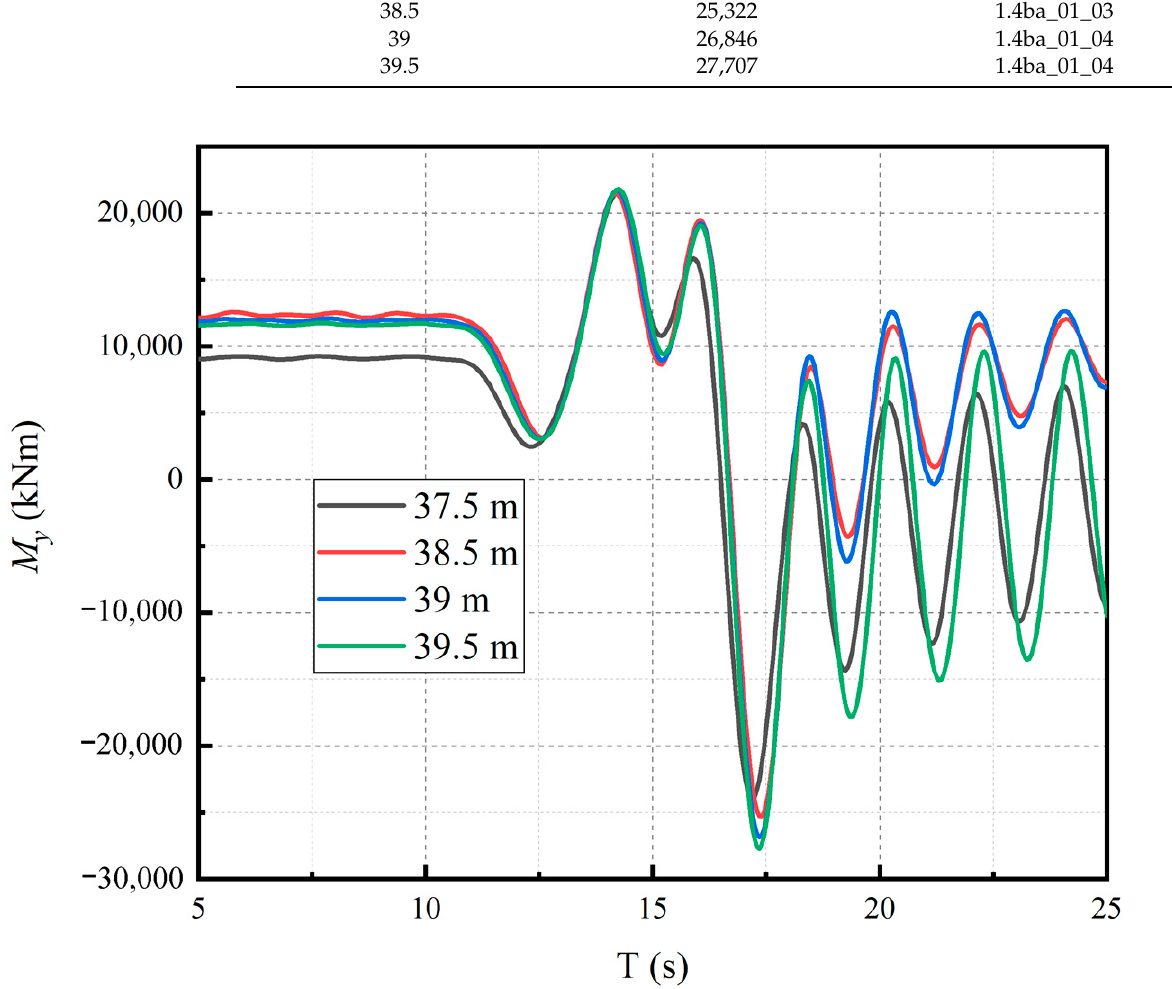
Figure 15. Load time series of M y at tower bottom.